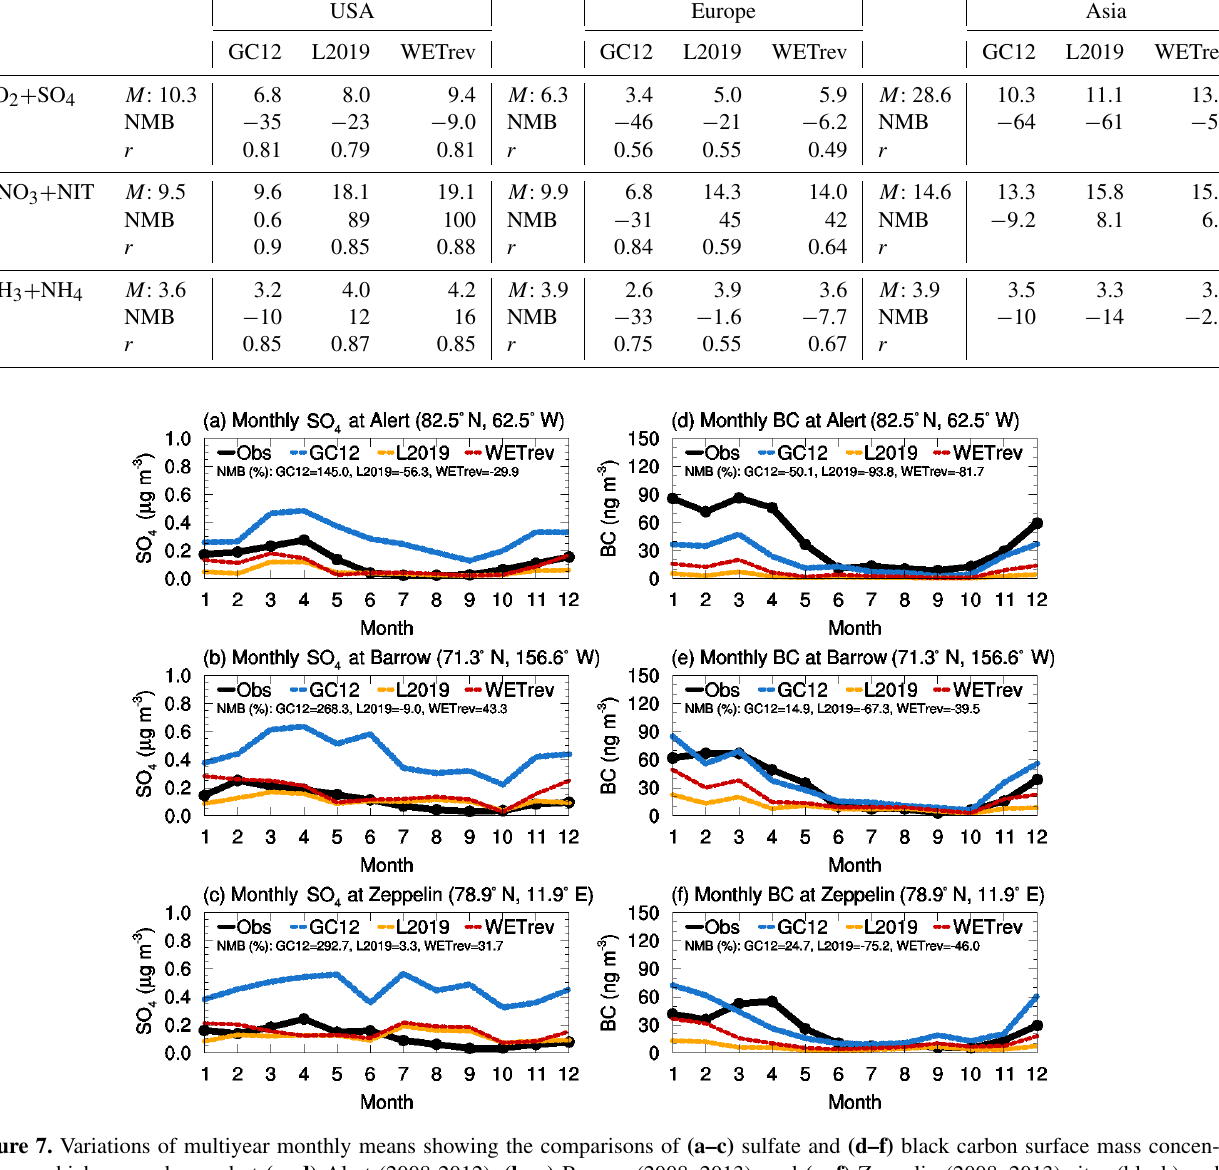
Table 6. Observed and simulated annual mean wet deposition of aerosols and aerosol precursors in the US, Europe, and Asia. Comparisons include annual mean wet deposition ( M , kgha − 1 yr − 1 ), normalized mean bias (NMB, %), and correlation coefficient ( r , when the number of samples > 10) between observed and simulated annual mean values by GC12, L2019, and WETrev cases. Simulated values at sites were corrected following Paulot et al. (2014) to remove bias due to precipitation.